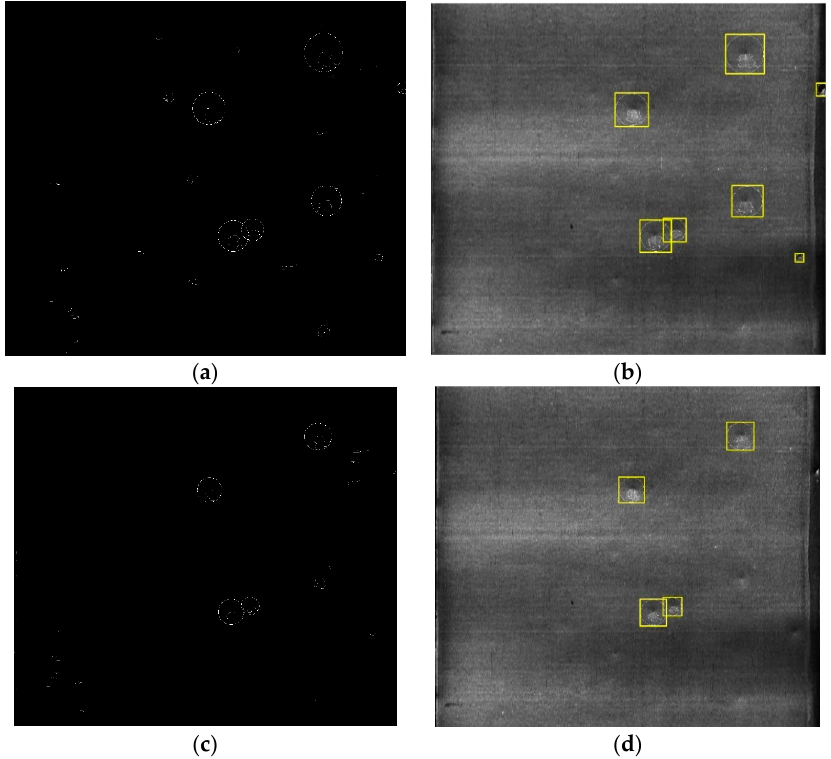
Figure 12. The inspection results of defects for concave and convex. ( a ) Result of boundary search of defects by partition method; ( b ) Result of defects marked on original image by partition method; ( c ) Result of boundary search of defects by traditional method without partition processing; ( d ) Result of defects marked on original image by traditional method without partition processing.